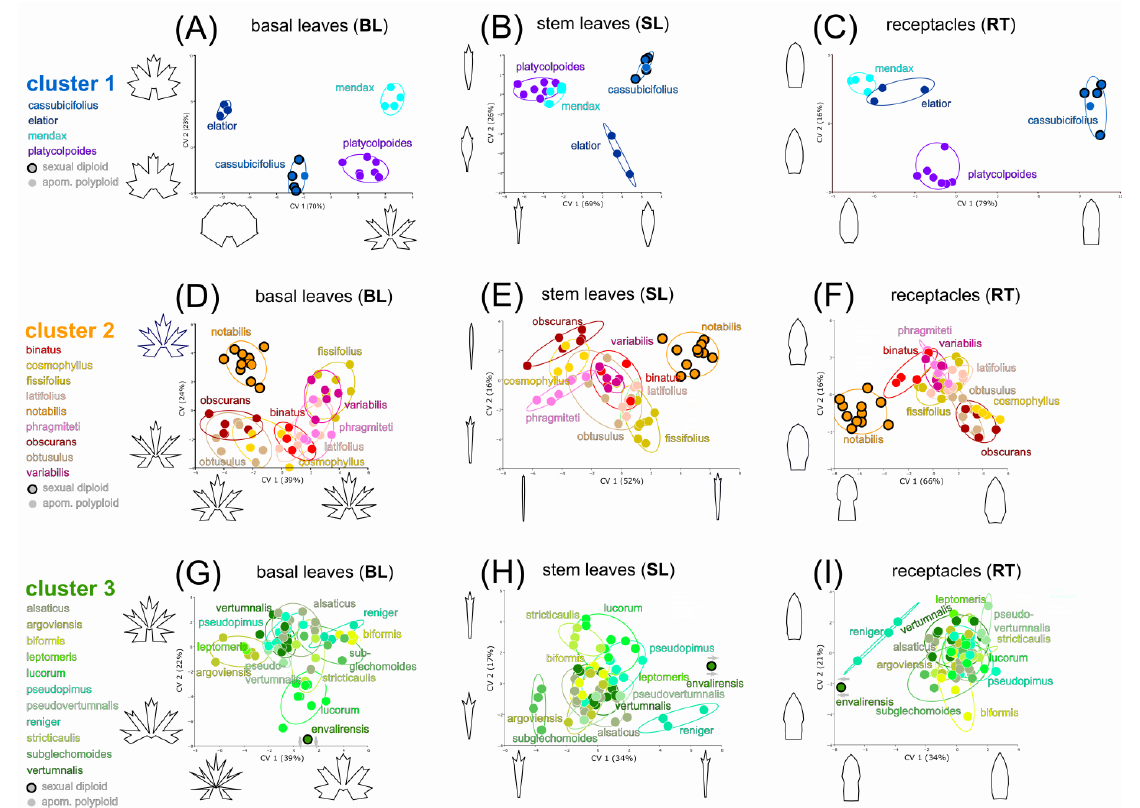
Figure 6. Morphological variation among sexual progenitors and polyploid apomictic derivative nothotaxa with respect to traits and genomic RAD-Seq (RADpainter) background. Canonical variate analyses (CVA) were applied for the clustering of twenty-four polyploid apomictic taxa based on the three morphological traits. Within cluster 1 ( A – C ), one sexual species and three apomictic polyploids were compared according to basal leaves ( A ), stem leaves ( B ), and receptacles ( C ). Within cluster 2 ( D – F ), one sexual species and eight apomictic polyploids were compared. In the case of cluster 3 ( G – I ), both sexual populations ( R. envalirensis ) were morphologically distant from all the polyploids, and their position within the plots was only graphically indicated by grey arrows. The coloring of sexual progenitors and clusters follows Figure 2 and [51]. BL = basal leaves, Cluster 1 = RAD- Seq (RADpainter) cluster 1 containing R. cassubicifolius and polyploid apomictic relatives, Cluster two = RAD-Seq (RADpainter) cluster 2 containing R. flabellifolius , R. marsicus , and R. notabilis and polyploid apomictic relatives, Cluster 3 = RAD-Seq (RADpainter) cluster 3 containing R. envalirensis and polyploid apomictic relatives; CV = canonical variate (explained percentages of shape variation); RT = receptacles; SL = stem